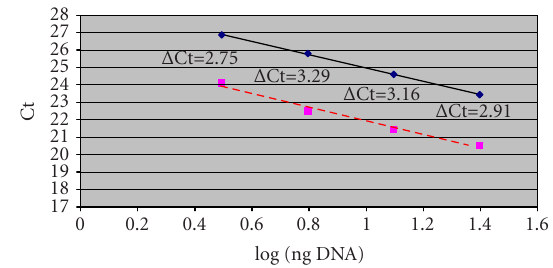
Figure 2. Multiplex and the 2 − ∆∆ Ct method validation: determi- nation and comparison of the PCR e ffi ciency for each gene. The straight side (dotted line) of the PCR of the referent gene (RNase P) with a slope = − 3 . 9 (eg, E = 80%). The straight side (contin- uous line) of the PCR of the CYP2D6 gene with a slope = − 3 . 8 (eg, E = 82%). After optimizing in simplex (matrix of primers) and carrying out a limitation of primers, this graph shows, on the one hand, that the e ff ectiveness of each PCR is practically identical and, on the other hand, that the use of the ∆∆ Ct calcu- lation method is validated. Variable amounts of genomic DNA, 25, 12 . 5, 6 . 25, and 3 . 125 ng, respectively, were used to draw these curves.